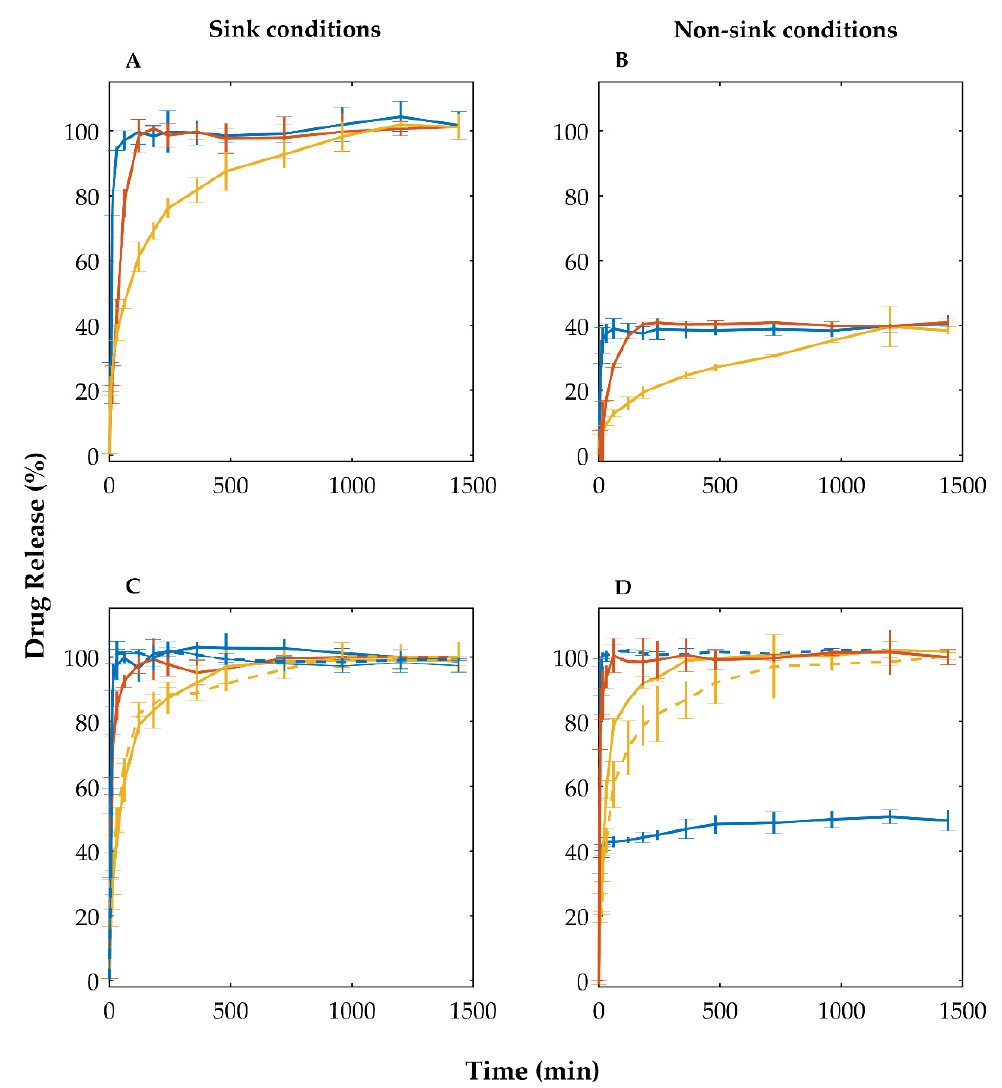
Figure 7. Dissolution profiles under sink (10 mg/L of OLZ, A , C ) and non-sink conditions (100 mg/L of OLZ, B , D ), of formulations I ( A , B ) and II (using the crystalline—solid line—or the co-amorphous form—dashed line—of olanzapine and saccharin, as starting materials) ( C , D ). Colors reflect the state of samples: physical mixtures (blue), uncoated pellets (yellow), and coated pellets (orange).